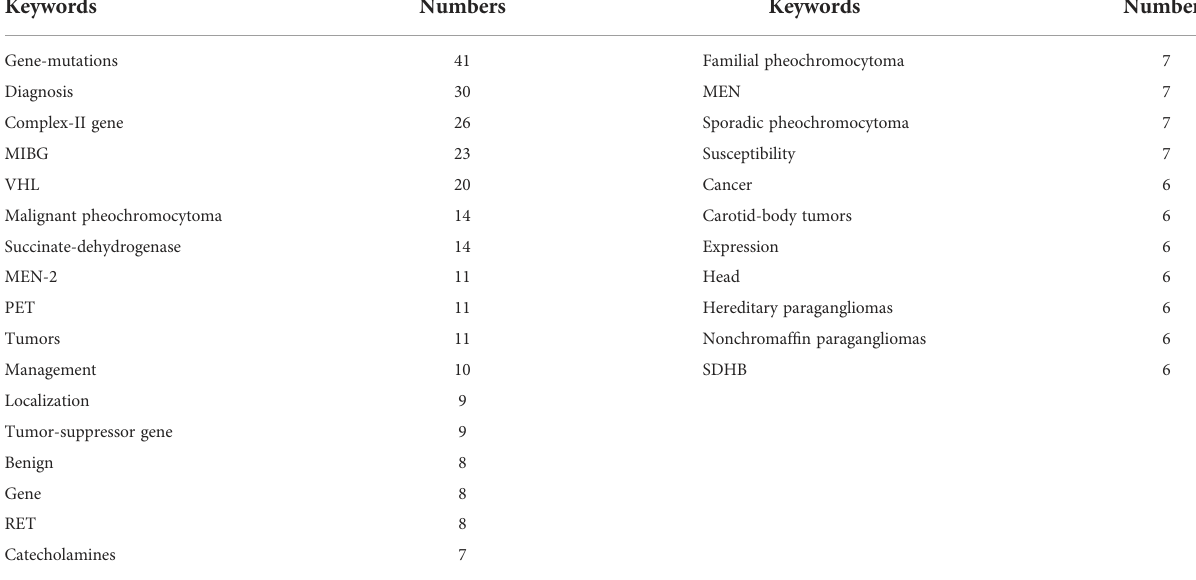
TABLE 6 Keywords that appeared at least fi ve times in the top 100 most-cited papers.